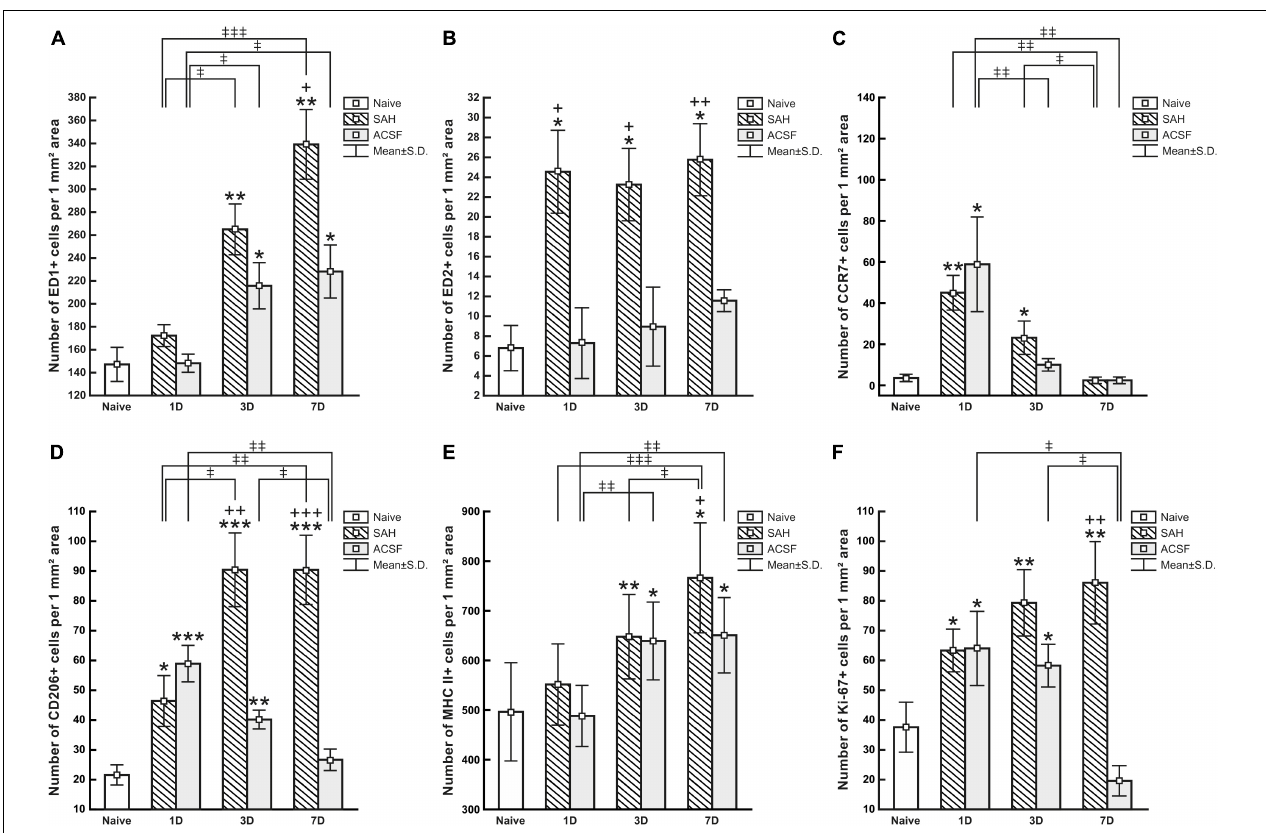
FIGURE 5 | Numbers of ED1+ (A) , ED2+ (B) , CCR7+ (C) , CD206+ (D) , MHC II+ (E) and Ki67+ (F) cells per mm 2 of CP from naive, ACSF and SAH rats at 1, 3, and 7 days after operation. Error bars indicate SD. *Indicates a significant difference when compared to CP from naïve rats (* p < 0.05; ** p < 0.01; *** p < 0.001). + Indicates a significant difference when compared to CP from ACSF rats ( + p < 0.05; ++ p < 0.01; +++ p < 0.001). ‡ Indicates a significant difference between the individual time points of survival ( ‡ p < 0.05; ‡‡ p < 0.01; ‡‡‡ p <